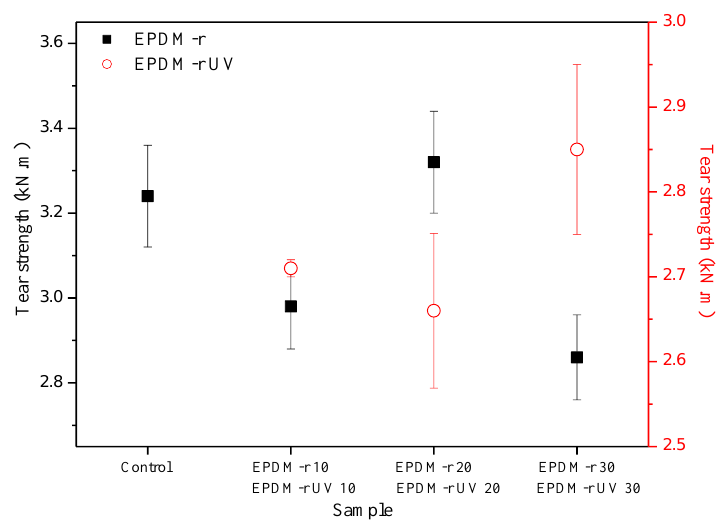
Figure 3. Tear strength of the analyzed samples.